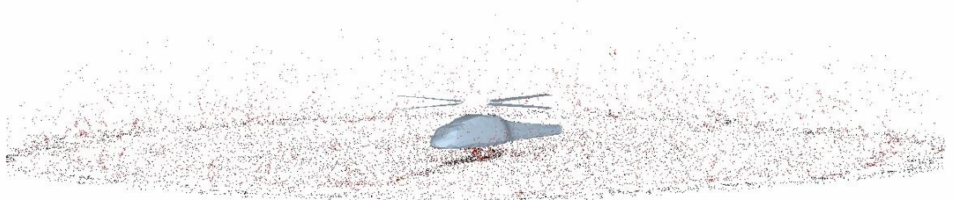
Figure 19. Distribution of sand particles.